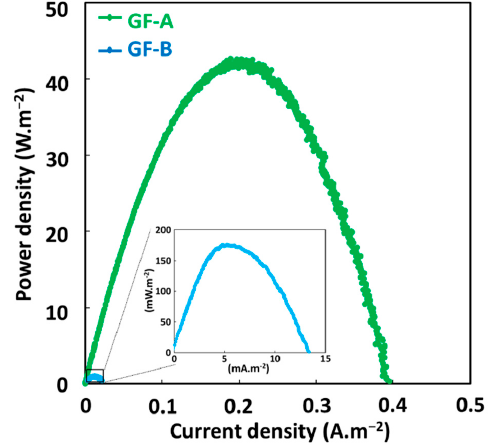
Figure 5. Power curves of the GF process obtained under GF-A (green line) and GF-B (blue line) conditions. 2.3. Effect of Anode/Cathode Area Ratio on GF Process Performances